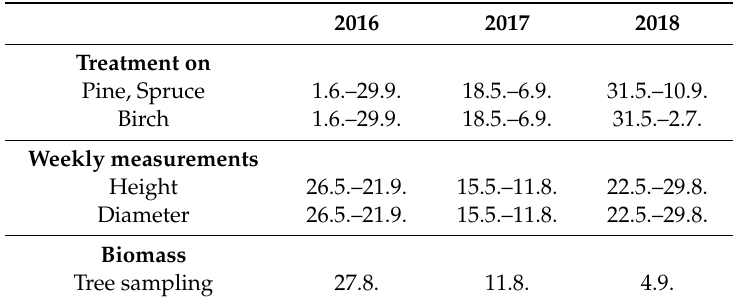
Table 2. Duration of warming-treatment time periods, growth measurements, and biomass sampling of each growing season of the